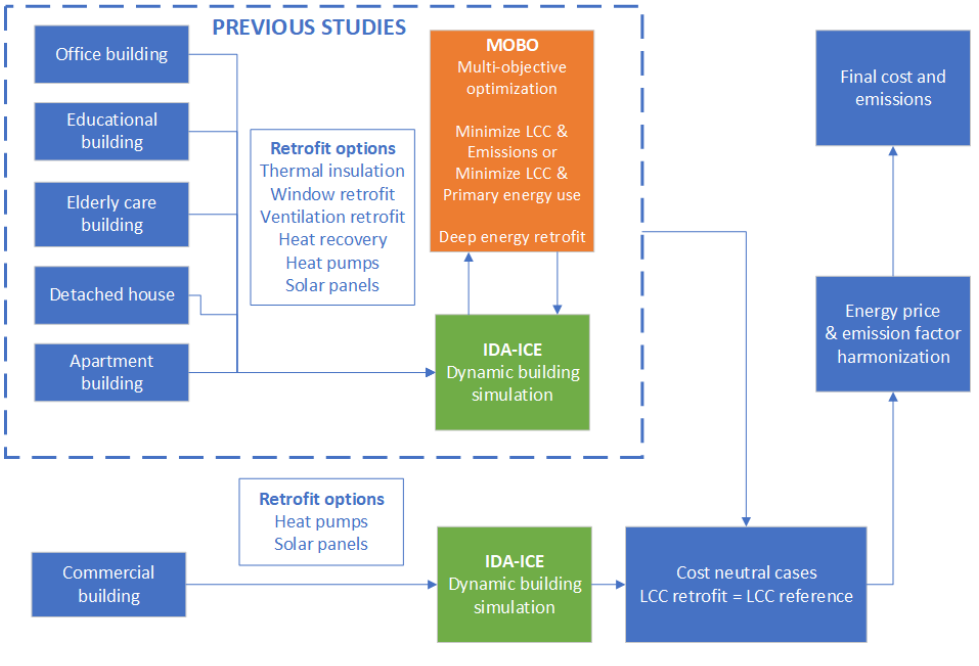
Figure 2. Flowchart of the calculation process.